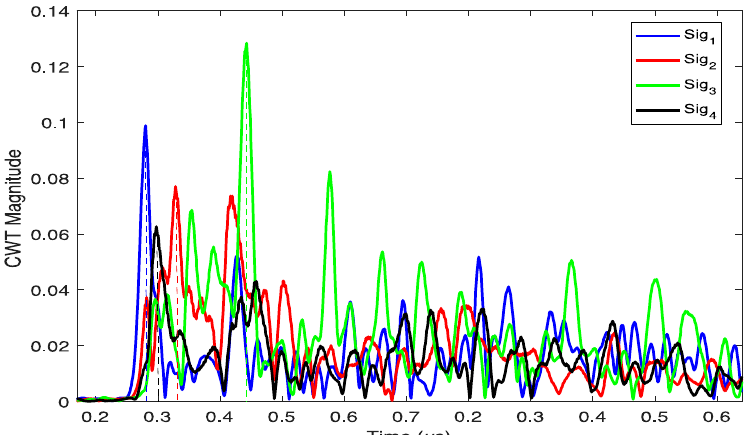
Figure 12. Identification of the time of arrival using the line profile of the scalogram at the average frequency 𝑓̅ = 283.3 kHz .